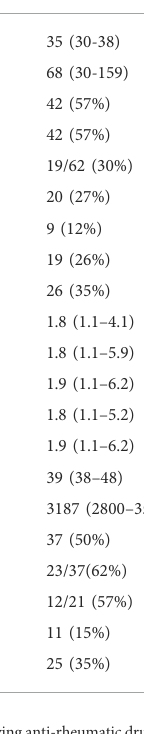
TABLE 1 Demographic, clinical, and neonatal characteristics of 73 pregnancies in patients with Rheumatoid Arthritis.